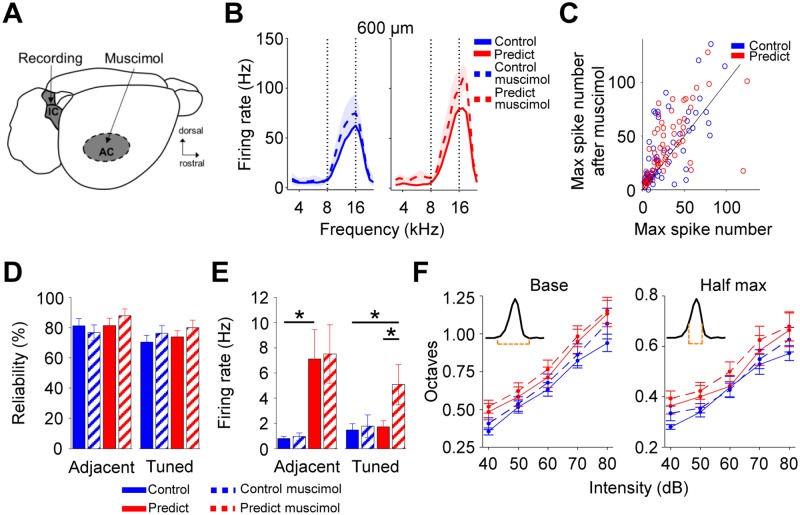
Cortical feedback does not influence sound exposure–induced
collicular plasticity.(A) Schematic representation of simultaneous collicular recordings and
cortical inactivation. (B) Average tuning curves at 600 μm for control
(left) and predictable (right) groups before (continuous lines) and
after cortical inactivation (dashed lines). (C) Pairwise comparison
between activity before and after cortical inactivation (wilcoxon rank
sum test, p = 0.4). Animals and recording sites:
control n = 7 and 62, predictable n =
6 and 64. (D) Mean response reliability for the adjacent (left, ANOVA,
group F1,88 = 1.22, p = 0.27) and tuned
(right, ANOVA, group F1,90 = 1.62, p = 0.2)
areas, before and after cortical inactivation. (E) Mean spontaneous
activity for the adjacent (left, ANOVA, group F1,92 = 13.23,
p < 0.001) and tuned (right, ANOVA, group
F1,94 = 3.98, p < 0.05. Corrected
pair comparisons: *p < 0.05) areas, before and after
cortical inactivation. (F) Mean bandwidth as a function of sound
intensity measured at the base (left, ANOVA, group F1,229 =
0.71, p = 0.4; muscimol F1,229 = 9.17,
p < 0.01) or at the half-maximum (right, ANOVA,
group F1,229 = 0.76, p = 0.38; muscimol
F1,229 = 4.86, p < 0.05) of the
tuning curve before and after cortical inactivation. Animals and
recording sites: control n = 7 and 30; predictable
n = 6 and 34. Error bars represent SEM. Numerical
data for this figure found in S1 Data. AC, auditory cortex; IC,
inferior colliculus.